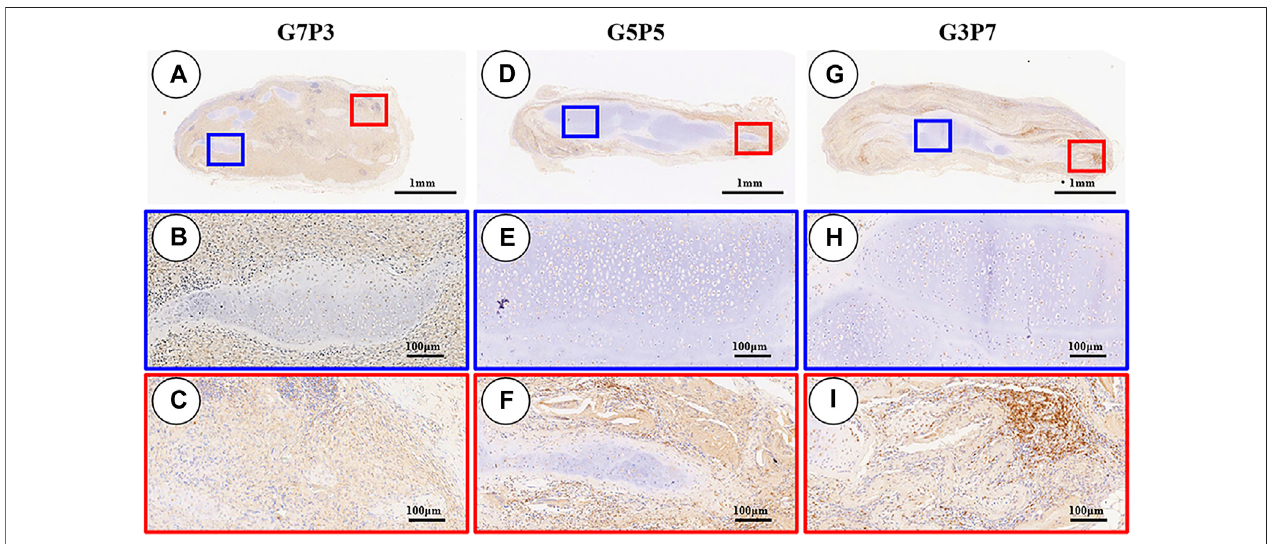
FIGURE7| In fl ammatoryreactioncharacterizedbyCD3staining.ThesamplesintheG7P3groupshowsmallandsparsecartilageislandssurroundedbyabundant CD3-positivecells (A – C) .IntheG5P5andG3P7groups,CD3-positivecellsareobservedintheouterandedgeregionsbutnotinthecentralregions (D – I) .Comparedto the G5P5 group (F) , more CD3-positive cells are observed among layered undegraded scaffold in the edge regions of the G3P7 group (I) .